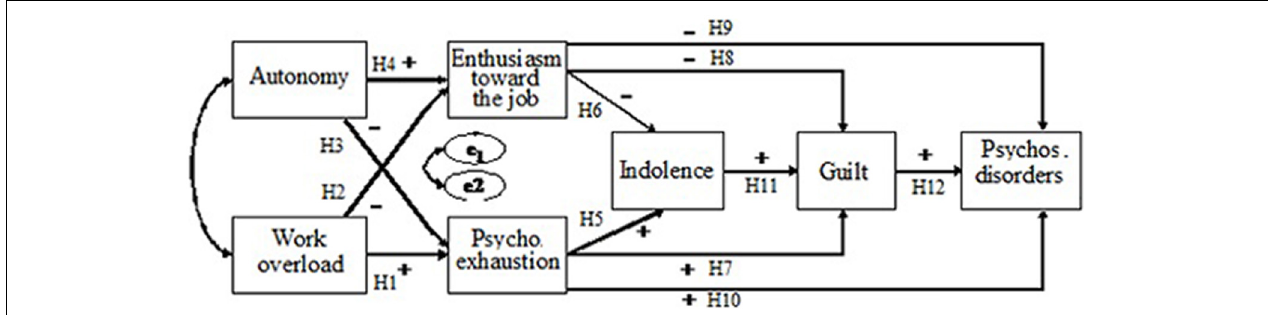
FIGURE 1 | Hypothesized